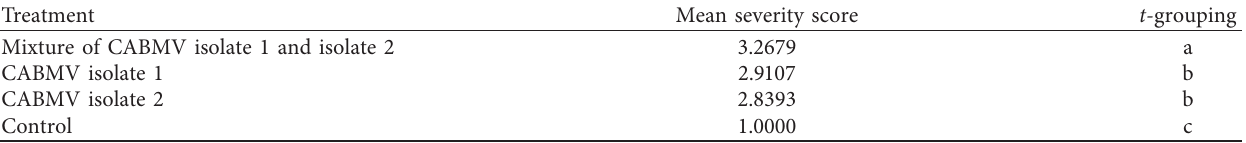
Table 1: Effects of CABMV isolates 1 and 2 and the mixture on P. edulis based on disease symptom severity. Treatment